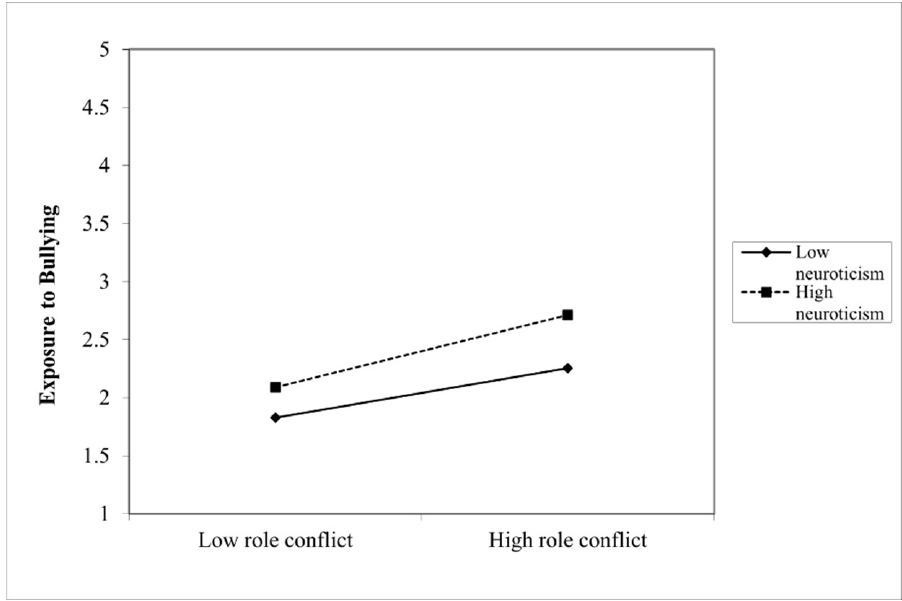
Figure 3. The moderating effects of neuroticism on the indirect effect of role conflict and exposure to bullying.